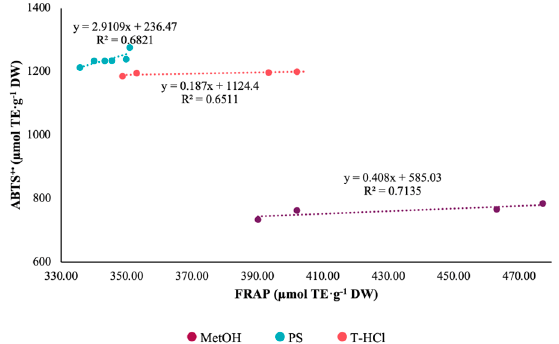
Figure 2. Pearson’s correlation of the FRAP and DPPH • assays of MetOH, PS, and T-HCl extracts.